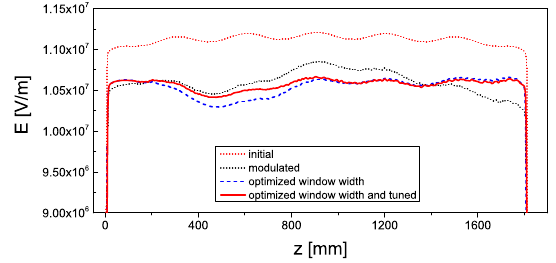
FIG. 13. On-axis longitudinal fields along the four-vane and window-type